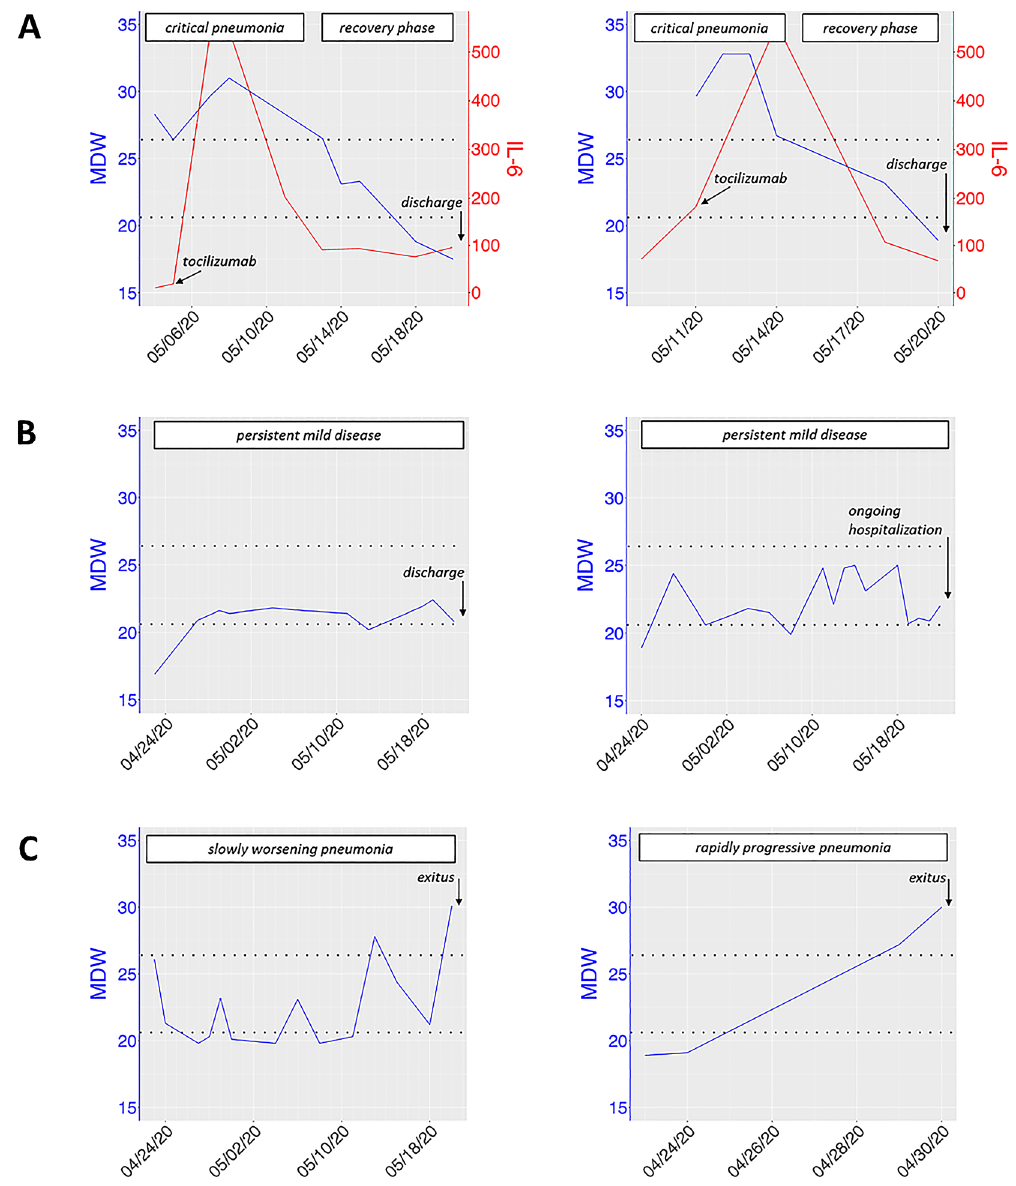
Figure 3. MDW patterns may depict clinical trajectories of COVID-19 patients. ( A ) Exemplificative clinical journeys of two COVID-19 patients with favorable outcome, both showing a critical phase (‘severe COVID-19’), followed by a complete recovery after anti-IL6R therapy (tocilizumab). In these patients, MDW reached high values (> 26.4), then, after immunosuppressive treatment, progressively decreased below negative threshold (< 20.5). MDW, blue line; IL-6 (pg/mL), red line. For MDW pattern comparisons, ( B ) two exemplificative COVID-19 cases without a critical respiratory impairment (thus not treated with tocilizumab), but with prolonged inflammation-driven illness and persistent low/mid-elevation of MDW values (ranging 20.5–26.4), as well as ( C ) two fatal COVID-19 cases, with MDW values progressively growing above